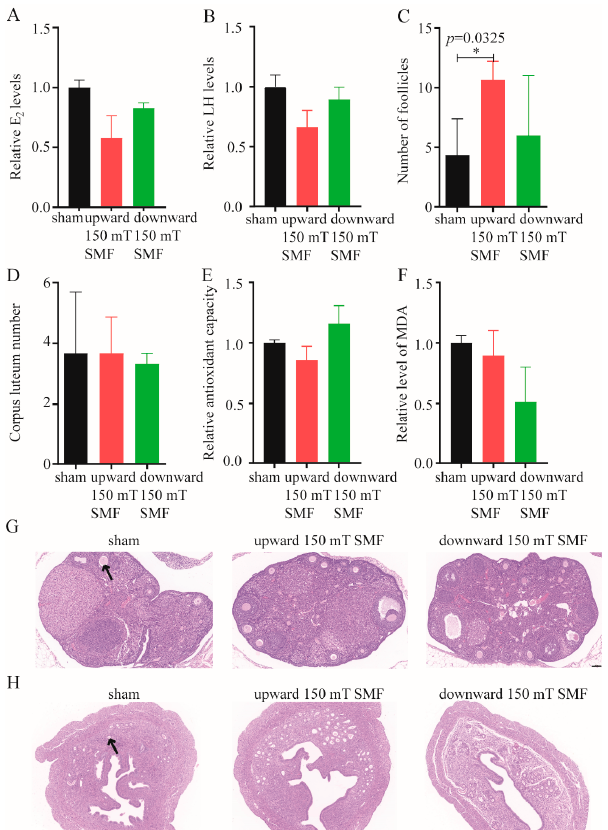
Figure 5. Effects of long-term 150 mT SMFs exposure improved the function of the ovaries and uterus in female mice. ELISA detected the E 2 ( A ) and LH ( B ) levels of mice that were exposed to sham and 150 mT SMFs for 18 weeks. Statistics on the number of follicles ( C ) and corpus luteum ( D ) in the mice that were treated for 18 weeks. Relative total antioxidant capacity ( E ) and MDA level ( F ) of mice were detected after long-term exposure of 150 mT SMFs and sham. Representative H&E staining showed the effects of long-term 150 mT SMFs exposure on ovarian ( G ) and uterine ( H ) structures in female mice, the arrows point to the follicles ( G ) and uterine glands ( H ) respectively. Scale bar: 100 μ m. We conducted statistical analysis for all data, and values show mean ± SEM, and “*” means p < 0.05. In consideration of the readability of the paper, no statistical significance ( p > 0.05) was not labeled uniformly.